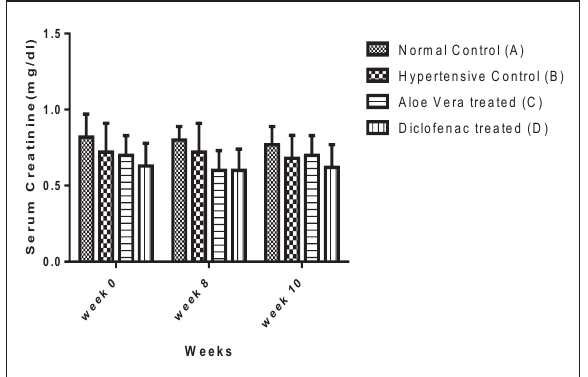
Fig-3: Effect of Aloe vera gel and diclofenac on serum creatinine (mean±SD) of hypertensive rats (n=6) Creatinine Clearance